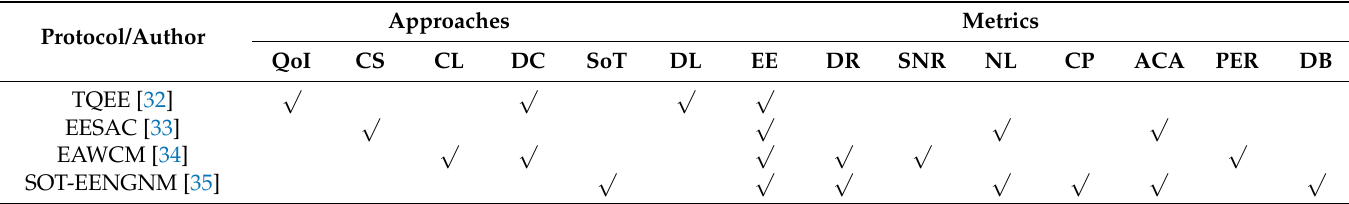
Table 5. Comparative assessment of energy efficient techniques at the sensing